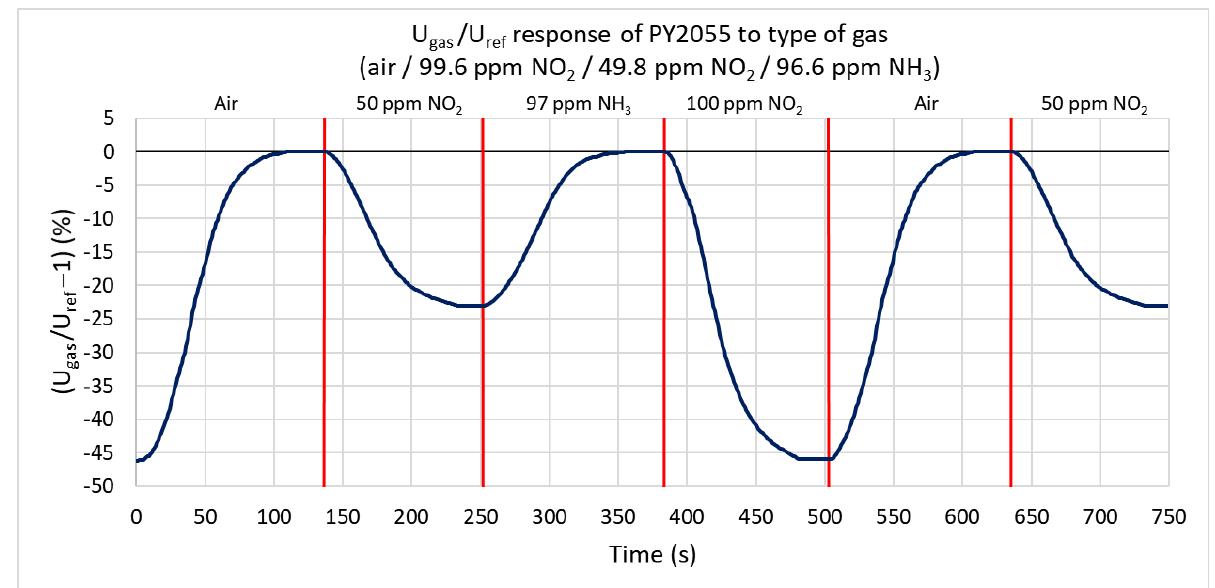
Figure 13. Response of PY2055 sensor to three types of gases (ammonia, nitrogen dioxide, and synthetic air) at a gas flow rate of 100 sccm.